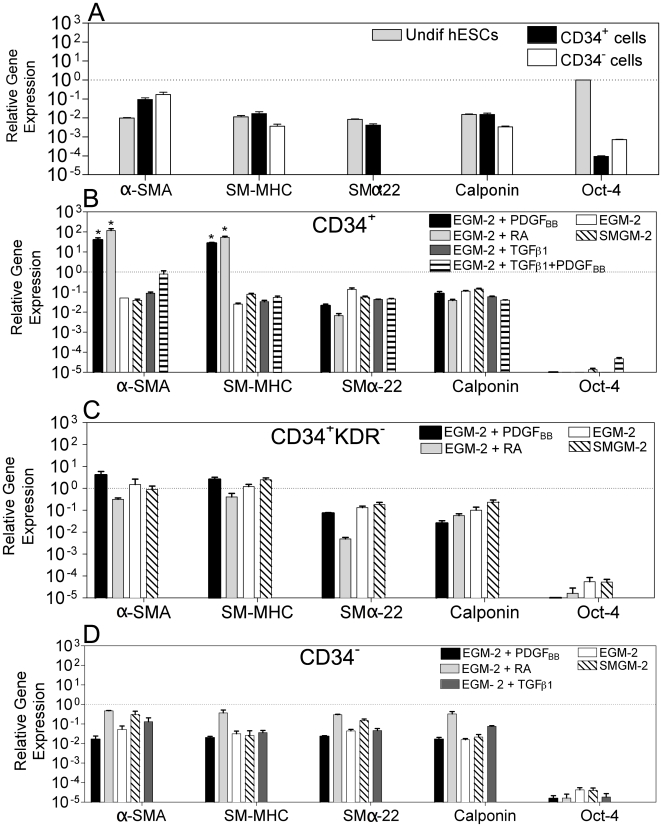
Gene expression in hESC-derived cells evaluated by qRT-PCR.Gene expression in each experimental group was normalized by the corresponding gene expression observed in hVSMCs. Oct-4 was normalized by the expression in undifferentiated hESCs. (A) Gene expression of hESCs, CD34+ and CD34− cells before differentiation. SMα-22 expression in CD34− cells is very low (<8.5×10−6) and not visible in the graph. CD34+ (B), CD34+KDR− (C), and CD34− (D) cells were cultured in SMGM-2 medium, EGM-2 medium, and EGM-2 medium supplemented with PDGFBB or TGFβ-1 or RA or TGFβ-1 plus PDGFBB. Cells were characterized at passage 4 (≈20 days). Results are Mean ± SEM (n = 4); * denotes statistical significance (P<0.05).